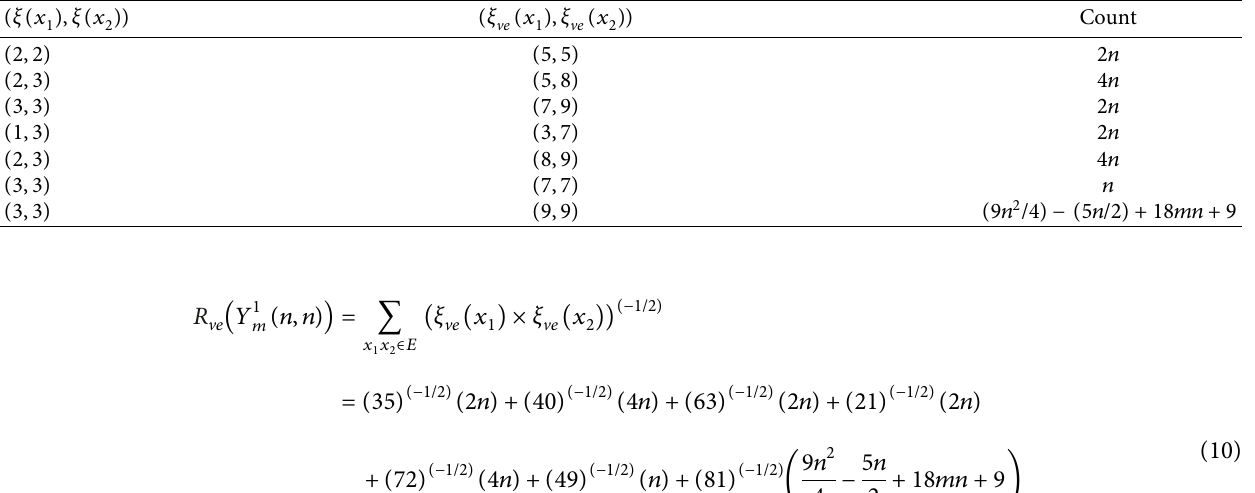
Table 2: The end vertices ve -degrees of each edge of Y 1